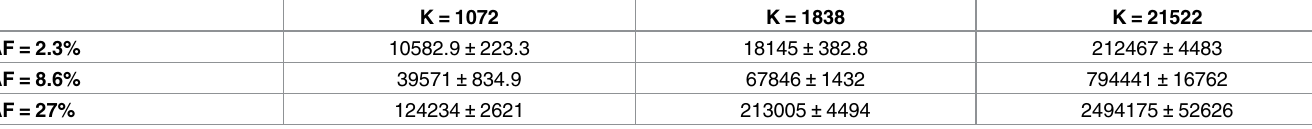
Table 4. Effect of handling surfacearea on estimated intake when concentrations in thermal paper are